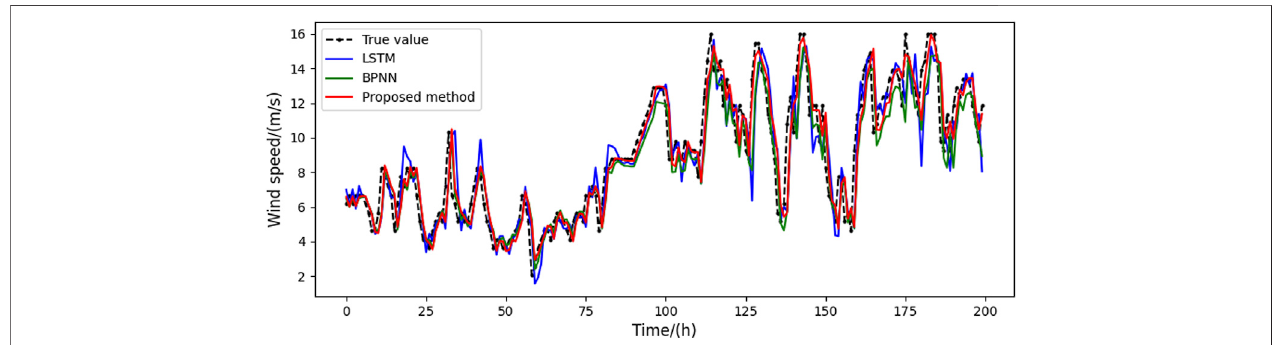
FIGURE 4 | Prediction results of three different methods in